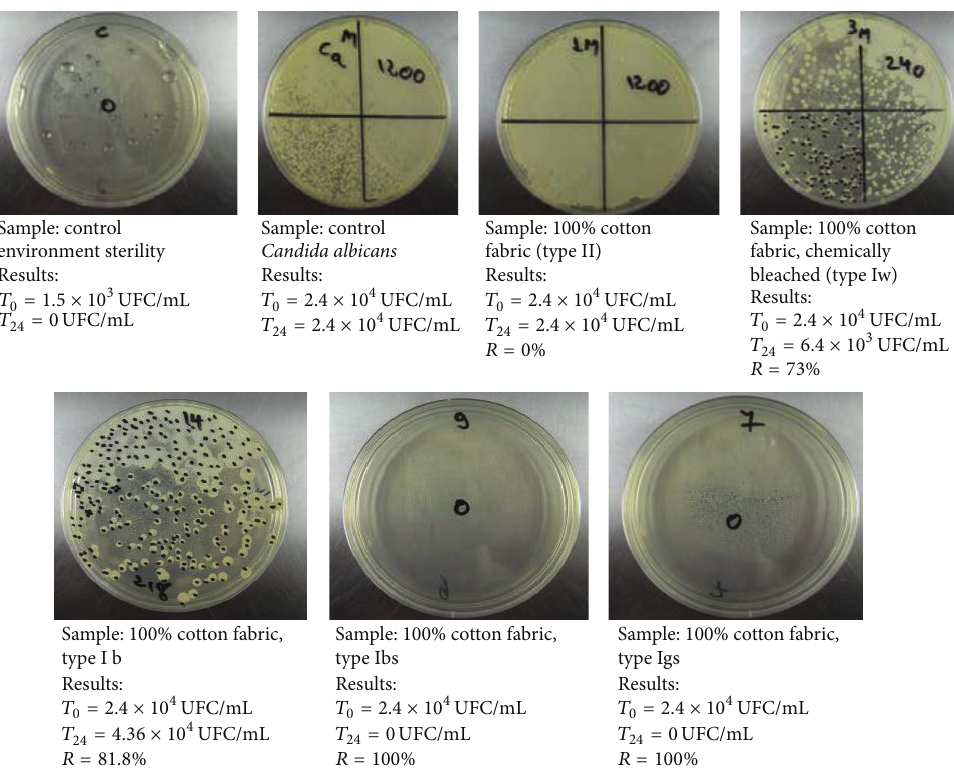
Figure 8: The result of microbiological tests on Candida albicans (according to ISO 20743:2007, absorption method).